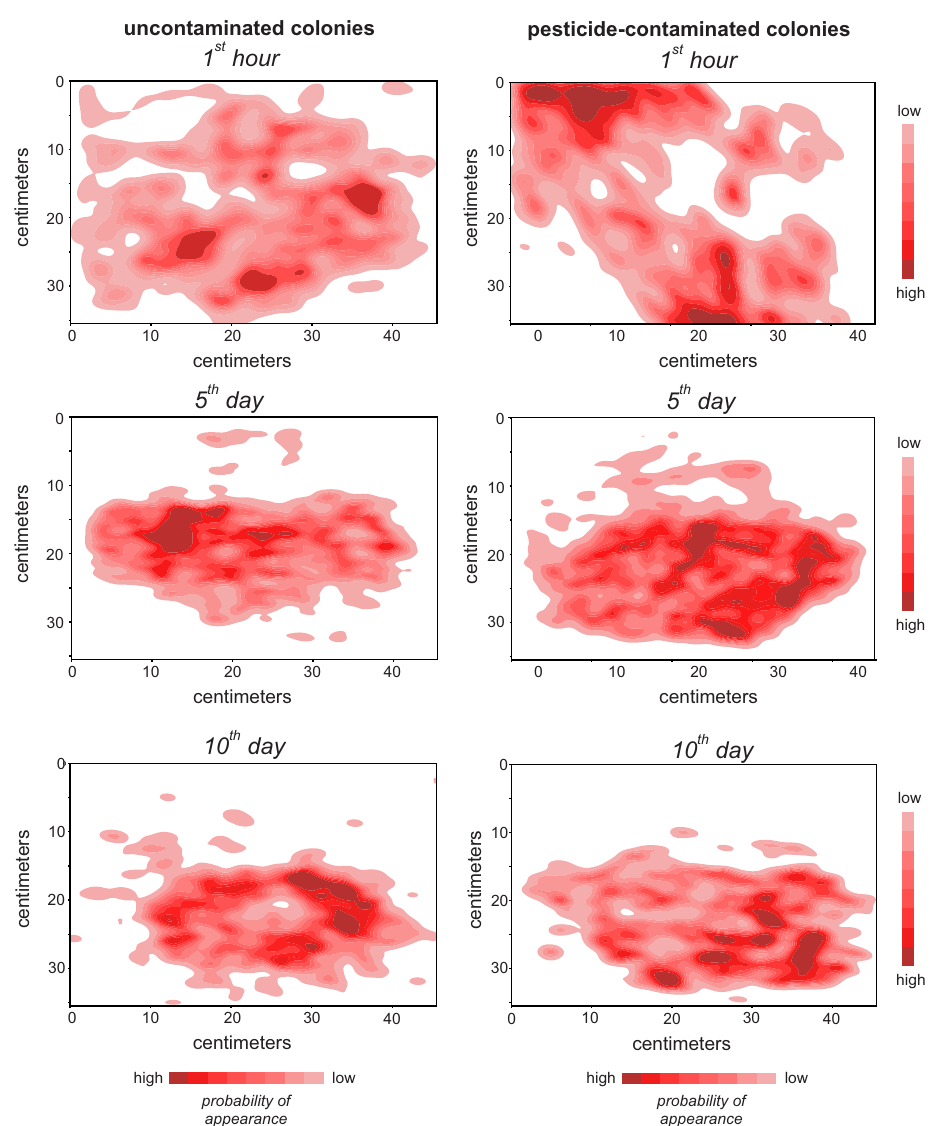
Figure 2. Spatial distribution of labeled Apis mellifera individuals at the 1st hour, 5th and 10th days after being introduced within a hive. Higher intensity color represents a higher probability of having a worker bee occupying the region. The labeled bees consisted of either pesticide-unexposed individuals (uncontaminated beehives) or individuals that were sublethally exposed to a commercial formulation containing the synthetic fungicides chlorothalonil and thiophanate-methyl (pesticide- contaminated beehives). The heatmaps indicate the number of labeled worker bee appearances in each comb region. As shown in Figure 1, the hive’s entrance is located at the lower right side of each panel